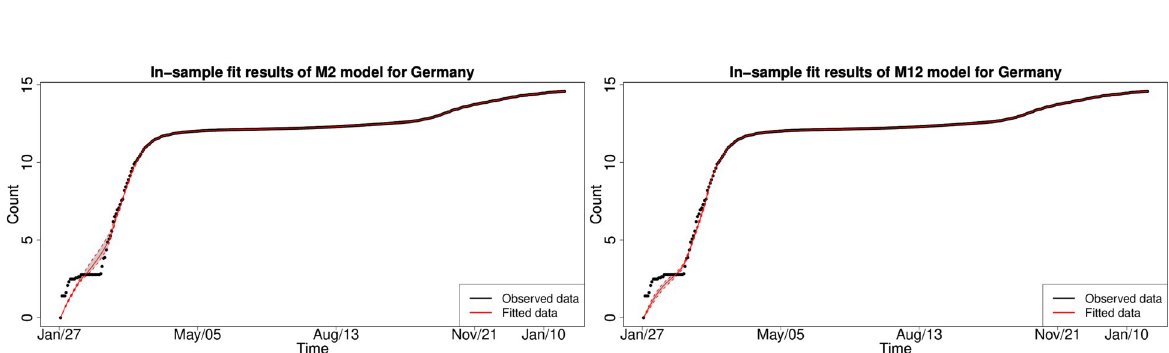
Fig 11. In-sample fit results for Germany for the period January 2020—January 2021. In-sample fitted plot (y-axis in log scale) for Germany by Model 2 (baseline, left) and Model 12 (best, right) (January 2020—January 2021).